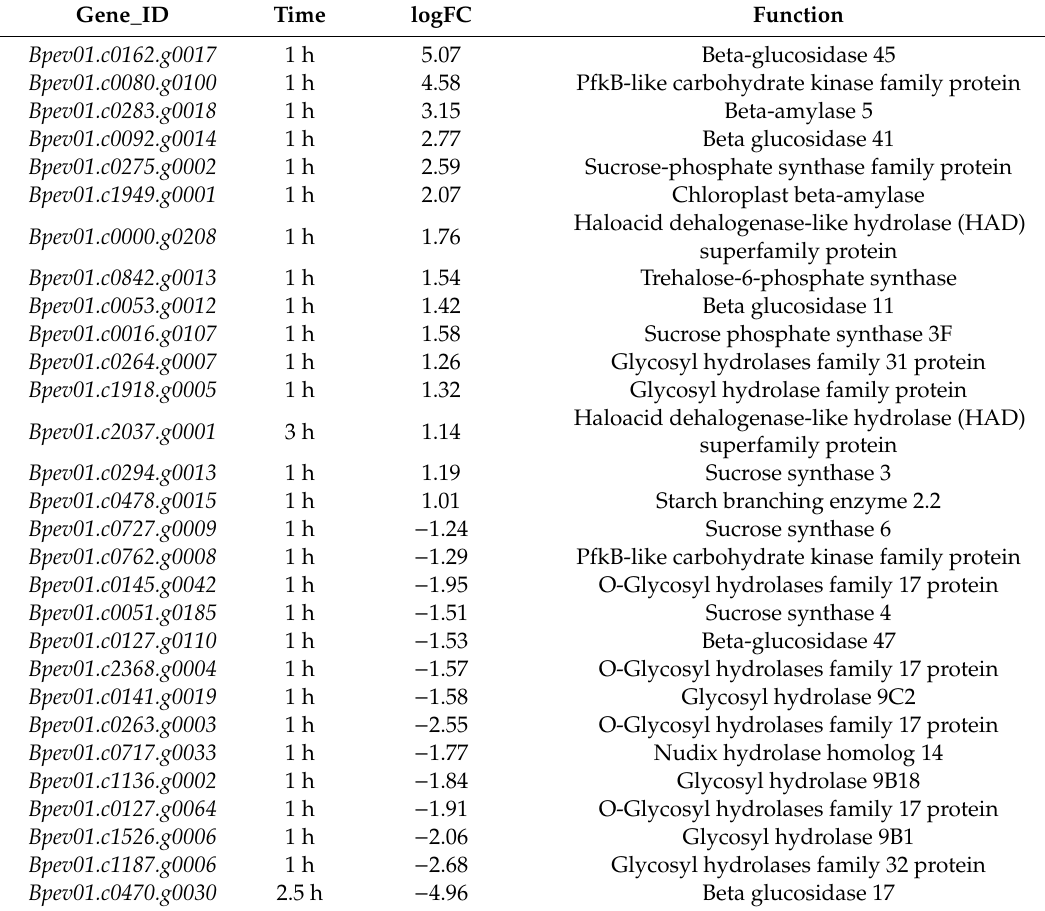
Table A6. Starch and sucrose metabolism-related DEGs under low-temperature stress in birch.